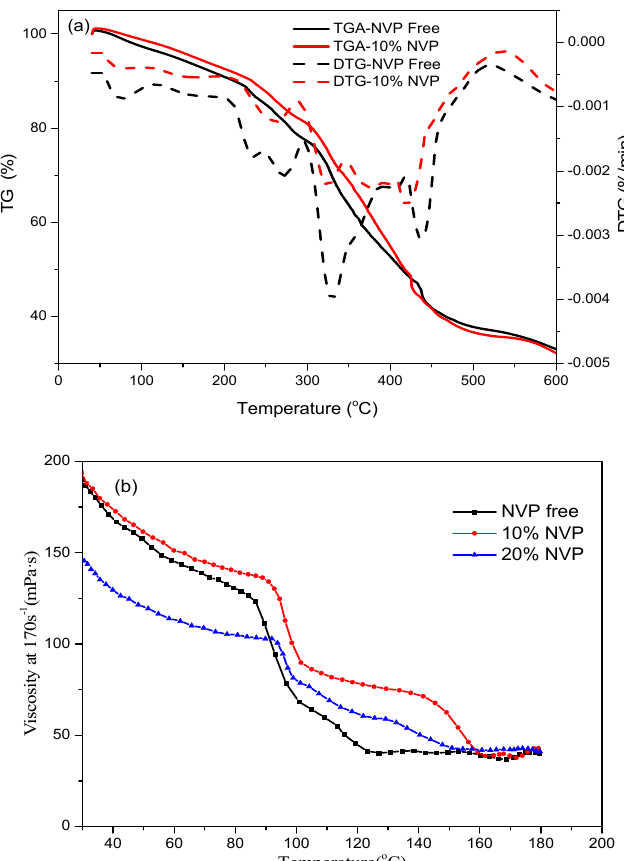
Figure 6. Effect of NVP on ( a ) thermal stability of polymer powders measured by TGA and DTG, and ( b ) viscosity of the polymer solutions (temperature ramp 3 °C/min).